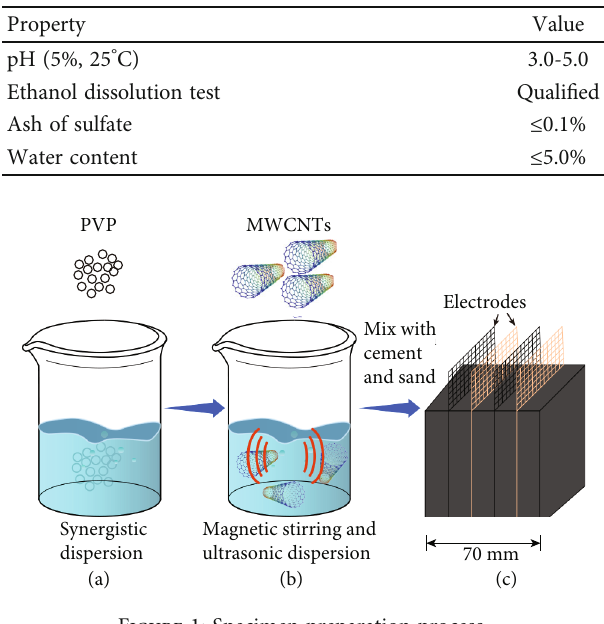
Figure 1: Specimen preparation